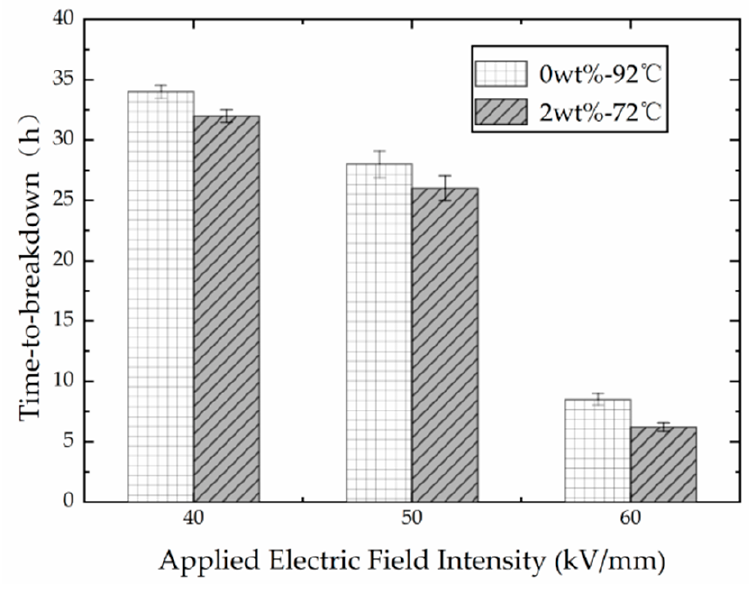
Figure 2. Time-to-breakdown vs applied electric field intensity of the compared two groups.